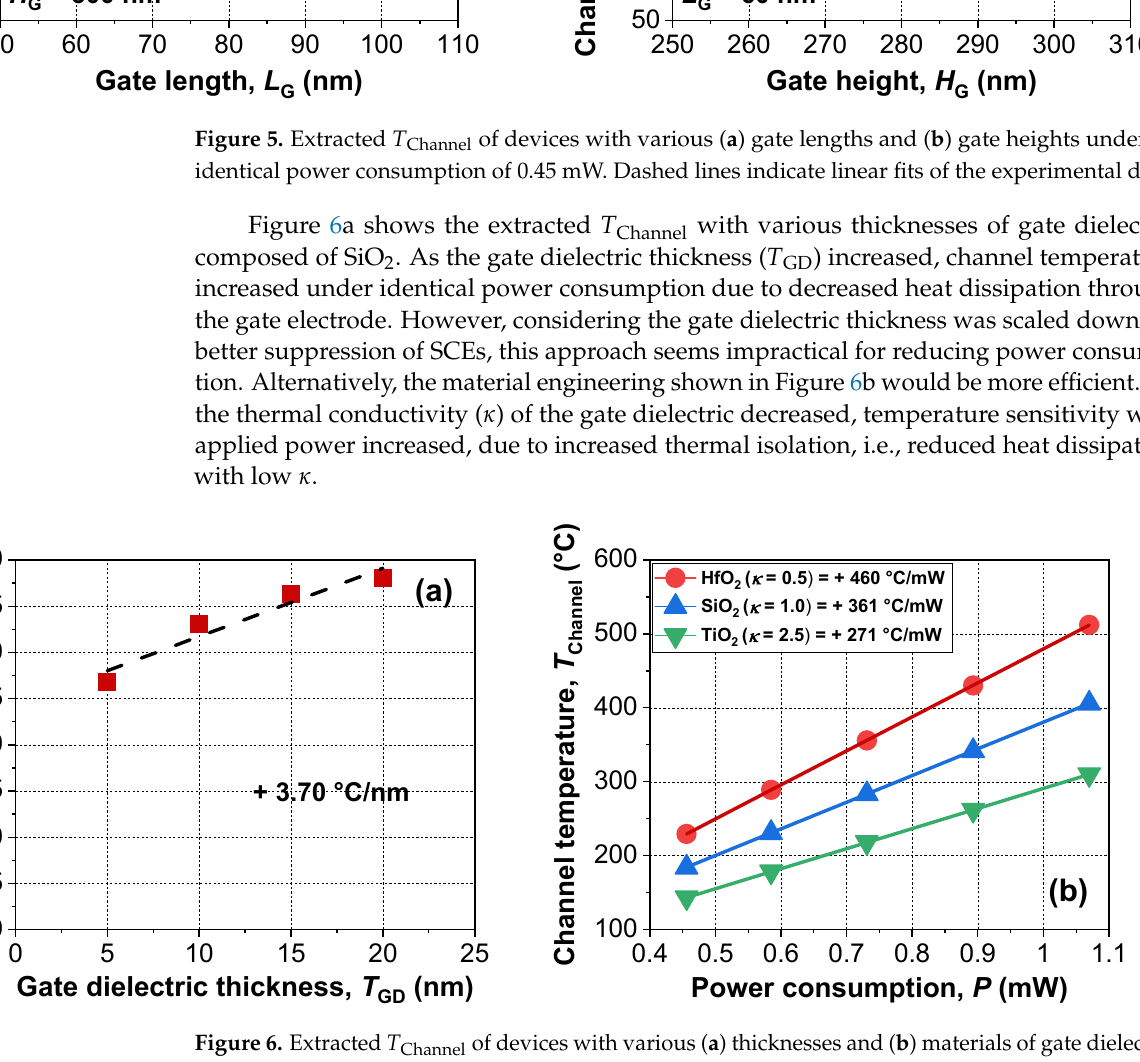
Figure 5. Extracted T Channel of devices with various ( a ) gate lengths and ( b ) gate heights under an identical power consumption of 0.45 mW. Dashed lines indicate linear fits of the experimental data.